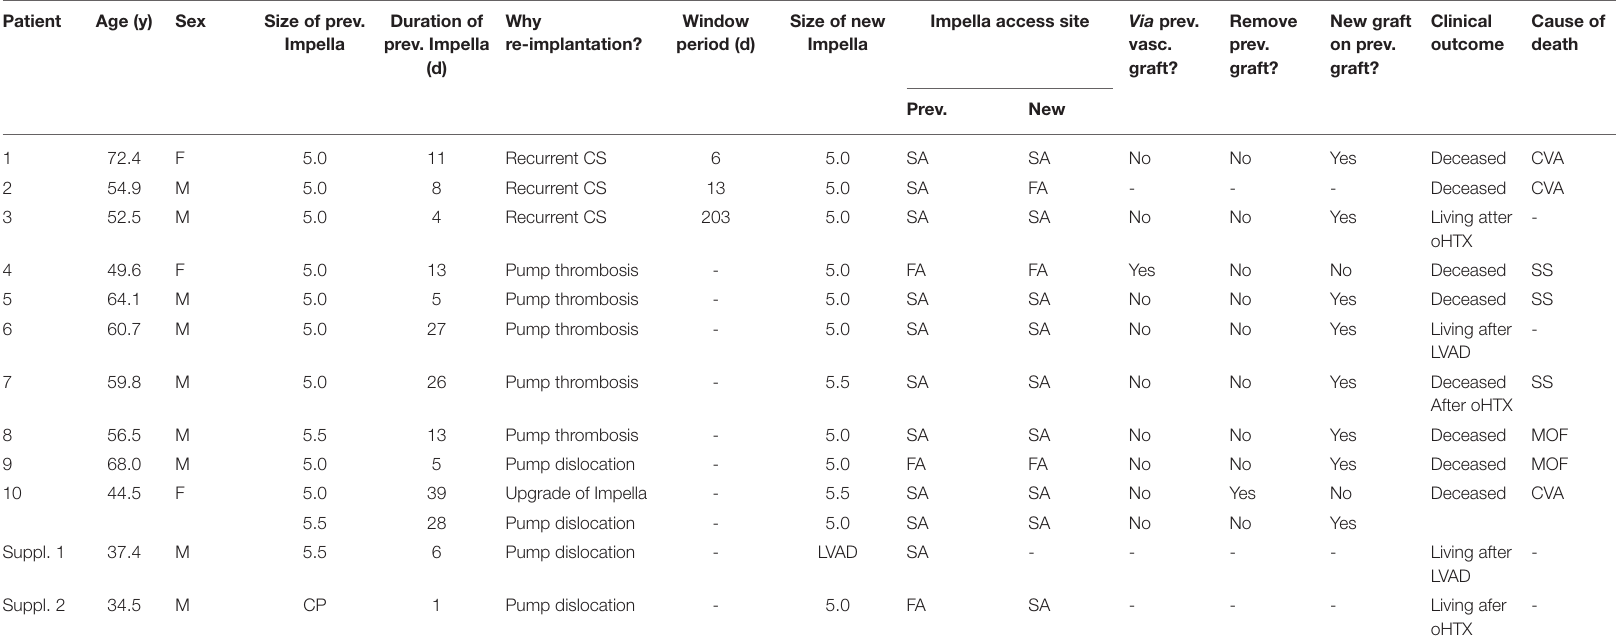
TABLE 5 | Re-implantation of Impella 5 + in 10 patients.